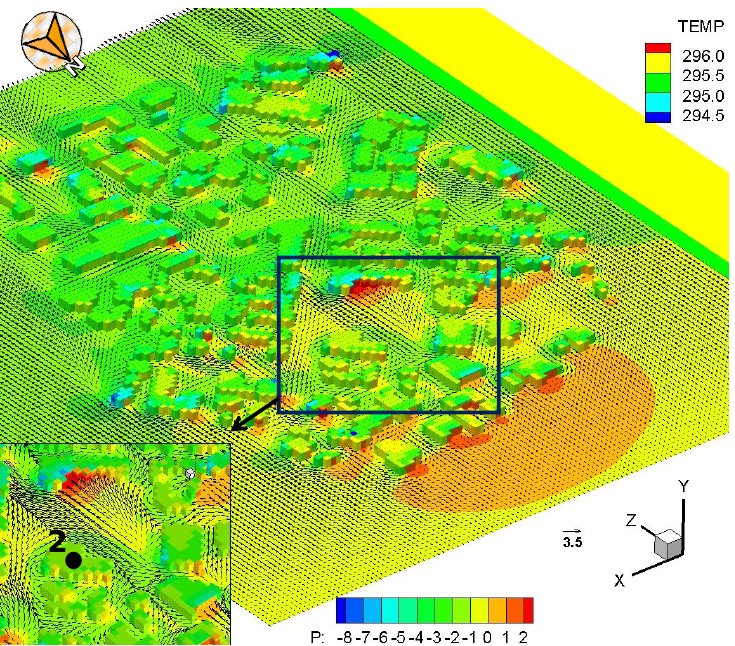
Figure 14. Contours of constant pressure (in Pa on XZ ground plane and building surfaces) and contours of constant temperature (in K on YZ plane). Insert is the region around the building where wind speed measurements were performed (point 2 in Figure 1). Atmospheric conditions corresponding to Pasquil E category (Table 1).